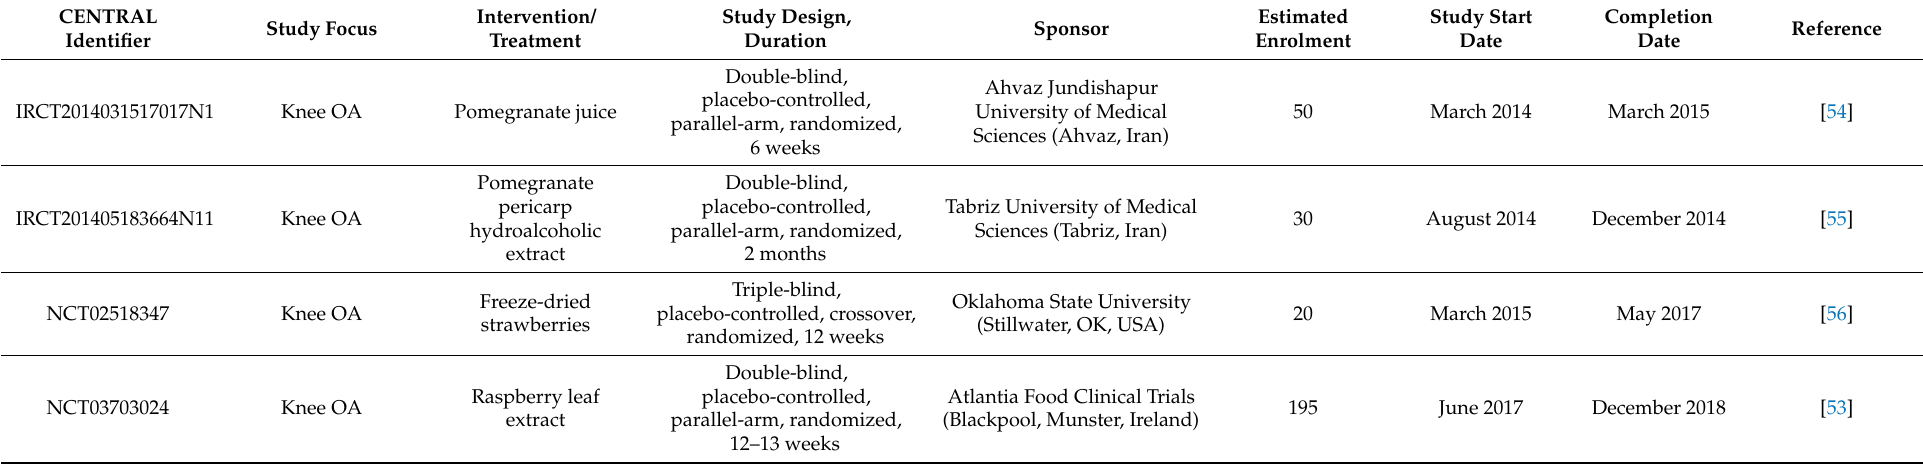
Table 2. Registered clinical trials testing the effects of HT-containing foodstuffs and products. Source: Cochrane Central Register of Controlled Trials (CENTRAL)